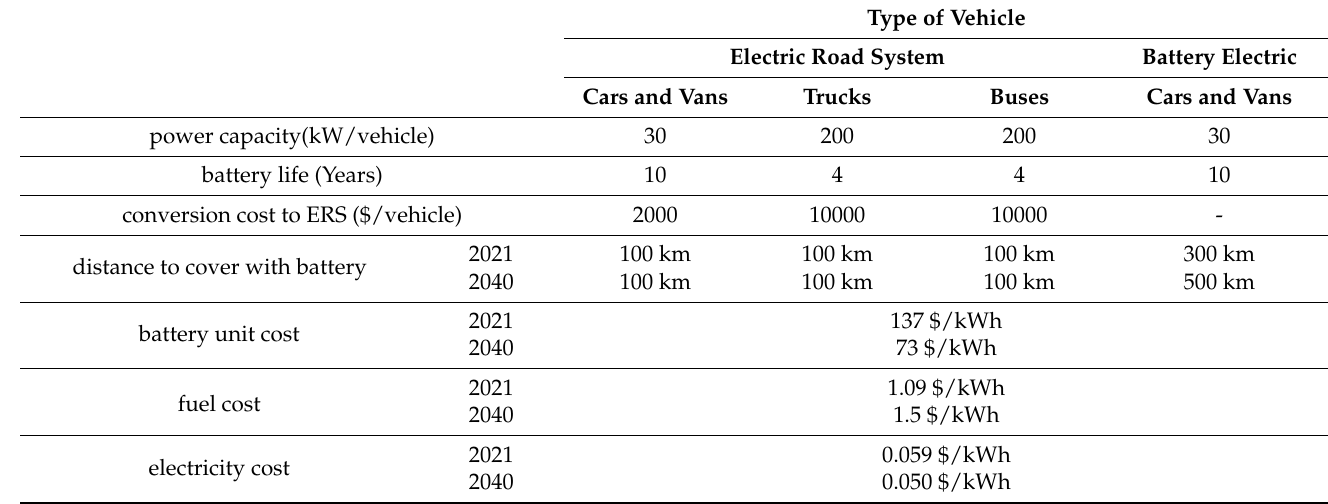
Table 5. Electric Vehicle and Battery Assumptions for 2021 and